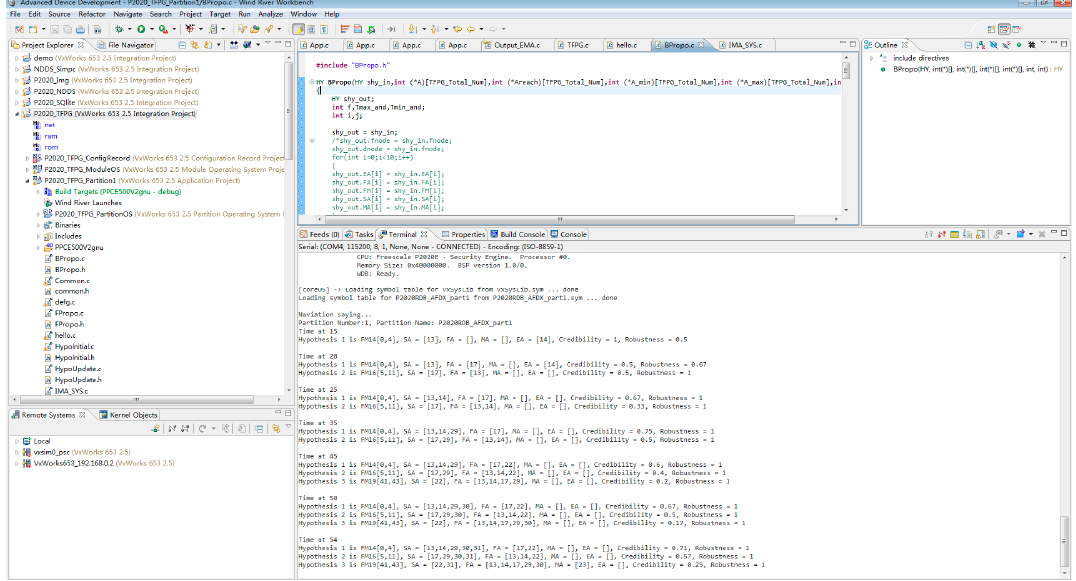
Figure 12. The real-time monitoring results of electromechanical actuator (EMA).